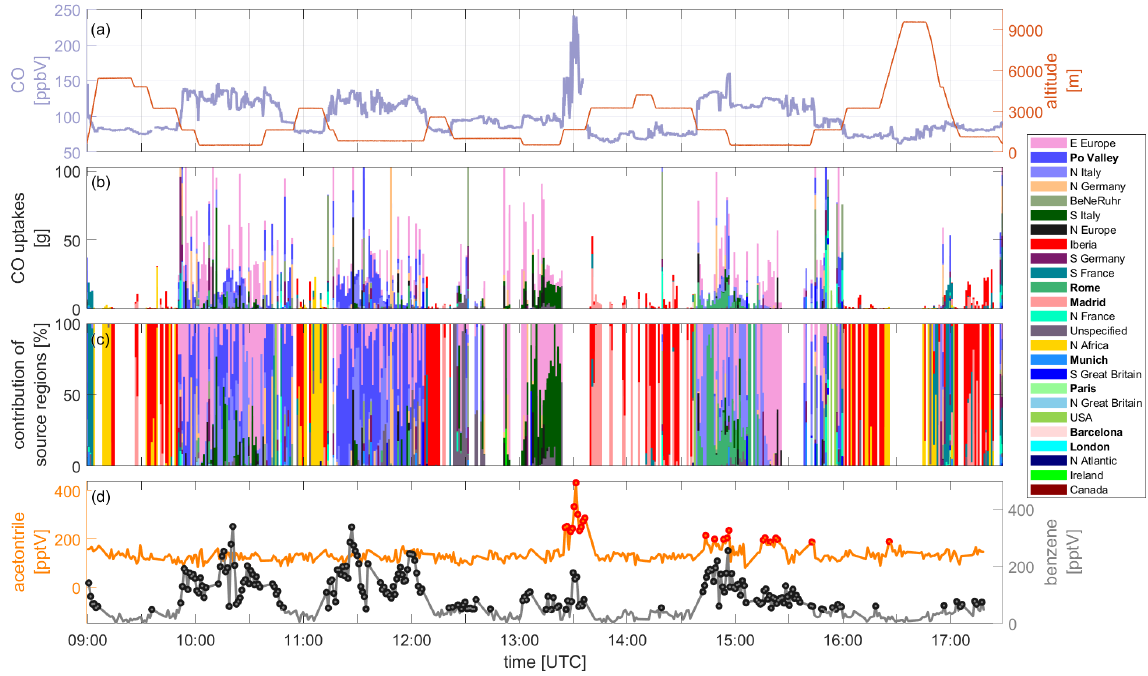
Figure 9. Time series of modelled source-region-specific CO uptakes and measured CO, acetonitrile and benzene for the EMeRGe-Europe flight EU-06, 20 July 2017, targeting Italian outflows. (a) CO measurements and flight altitude, (b) modelled CO uptake sums along 10d back trajectories colour-coded by originating source regions (sorted by total flight uptake sums – top to bottom, MPCs in bold), (c) relative contribution of source regions on CO uptake sums, and (d) acetonitrile and benzene measurements with colour-coded tracer enhancements over defined threshold (red and black dots,